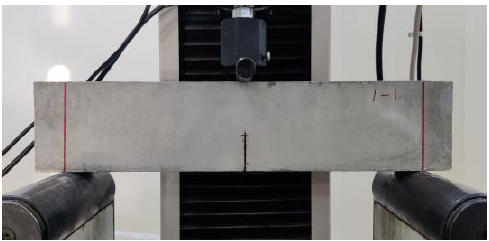
Figure 5. Dimensions of three-point bending test piece.